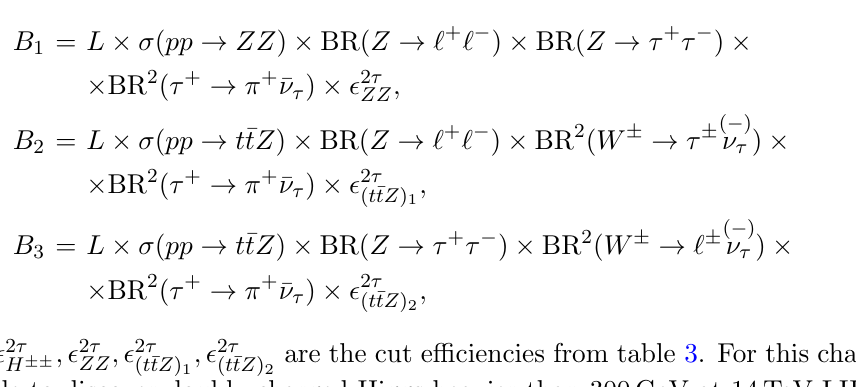
= 800 GeV. H (cid:6)(cid:6)